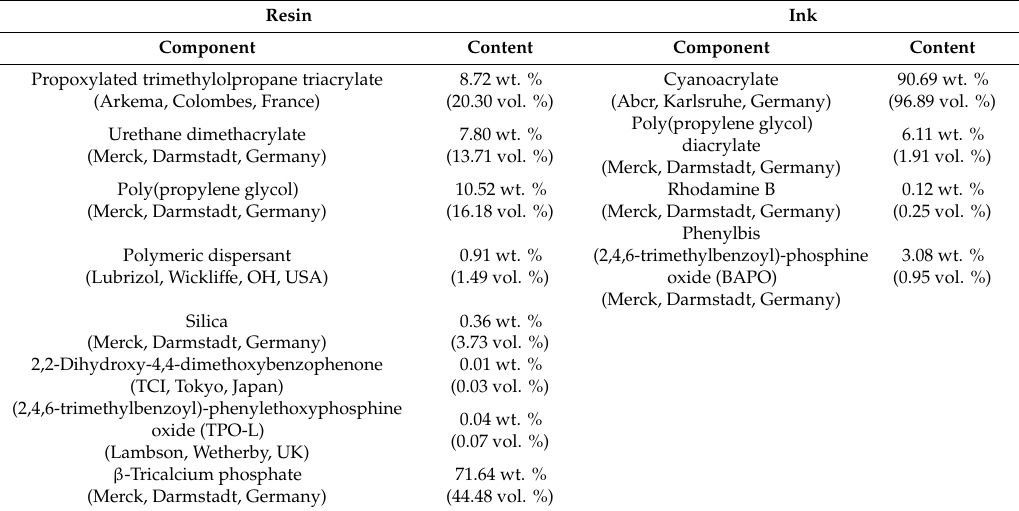
Table 1. Composition of photocurable resin and ink